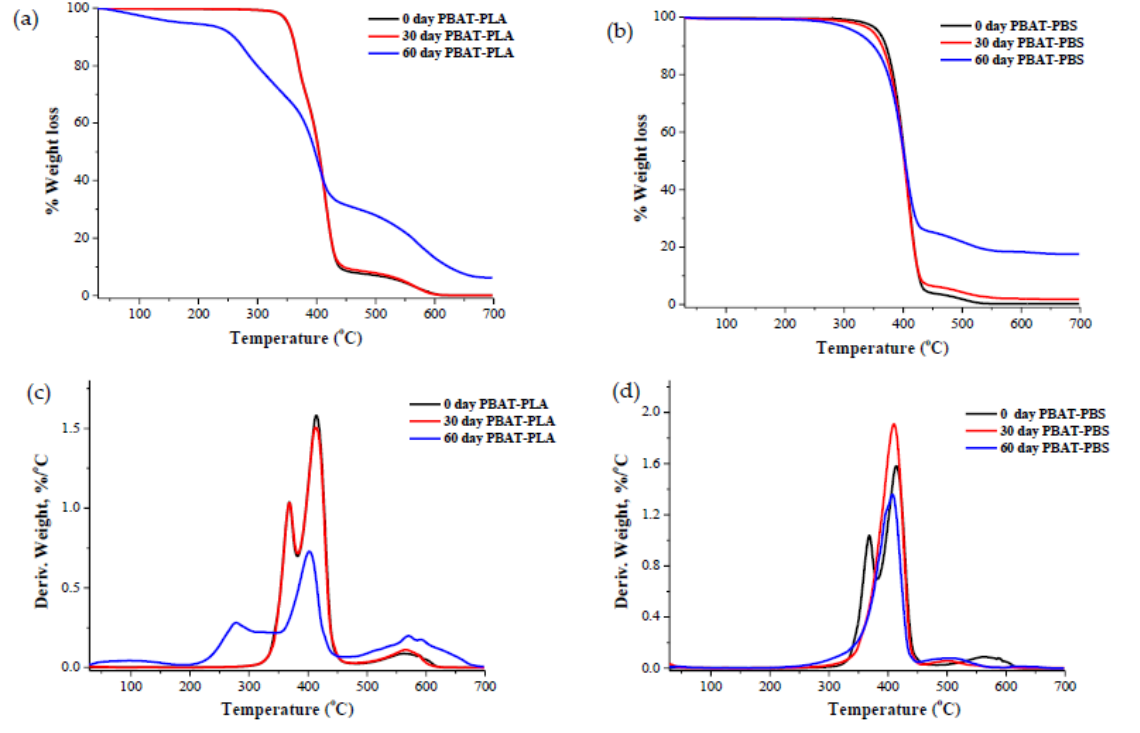
Figure 3. ( a ) TGA curves of the PBAT–PLA samples before, during and after degradation; ( b ) TGA curves of the PBAT–PBS samples before, during and after degradation; ( c ) the DTG curves of the PBAT–PLA samples before, during and after degradation; and ( d ) the DTG curves of the PBAT–PBS samples before, during and after degradation. Table 3. TGA results for the PBAT–PLA and PBAT–PBS blends, as well as pure PLA, PBAT and PBS.